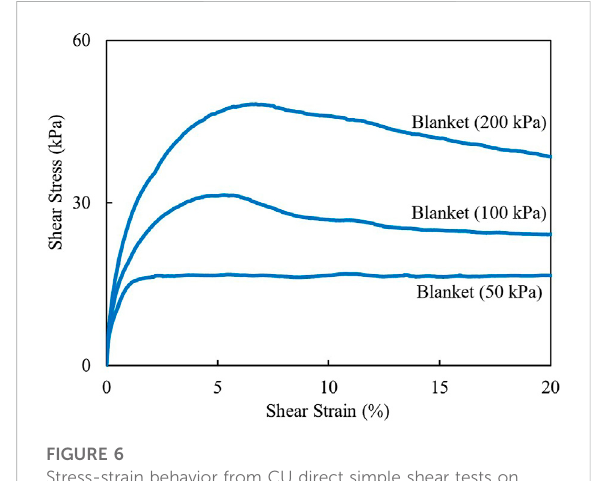
FIGURE 4 Porewater pressure measurements from CIU triaxial tests on CB clay core samples.